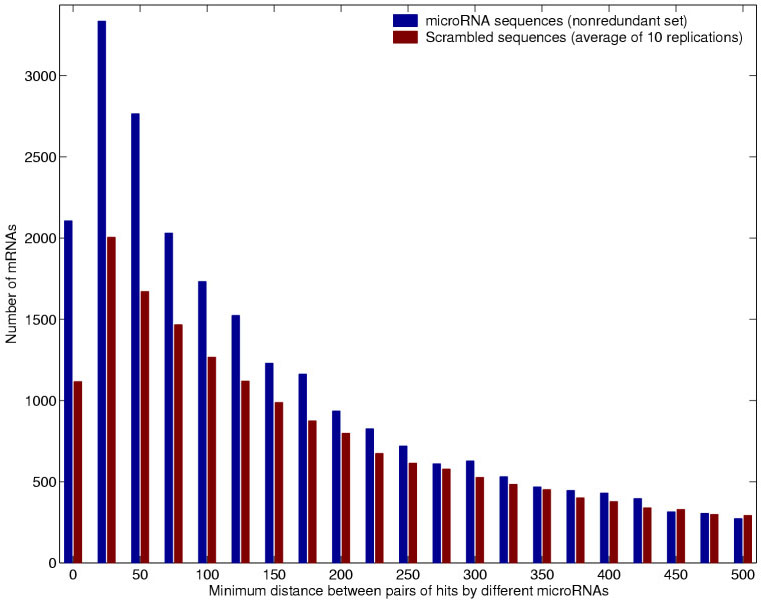
Number of distinct mRNA sequences which received hits from two or more distinct microRNAs, as a function of the minimum distance between hits. Distance of 0 or 1 was excluded because this might be produced by partial overlap of microRNA sequences.